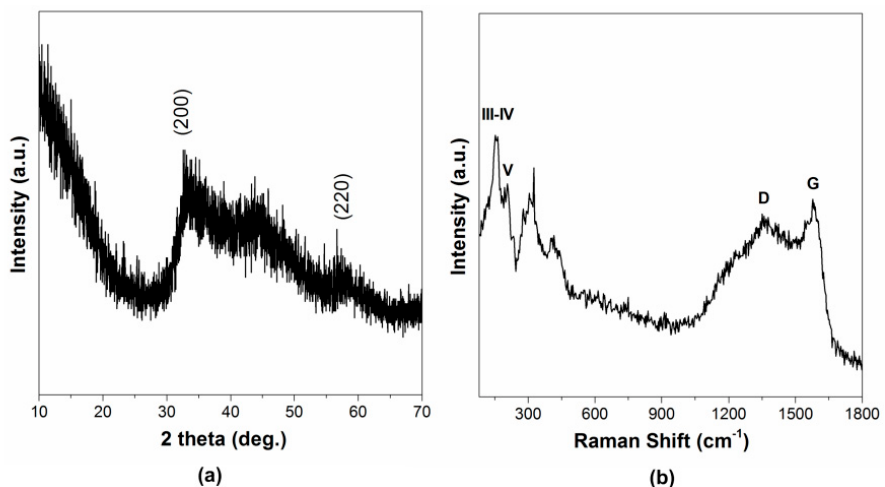
Figure 1. ( a ) X ‐ ray Diffraction (XRD) pattern and ( b ) Raman spectra of ReS 2 /C nanolayers annealed at 400 °C for 1 h under argon atmosphere.